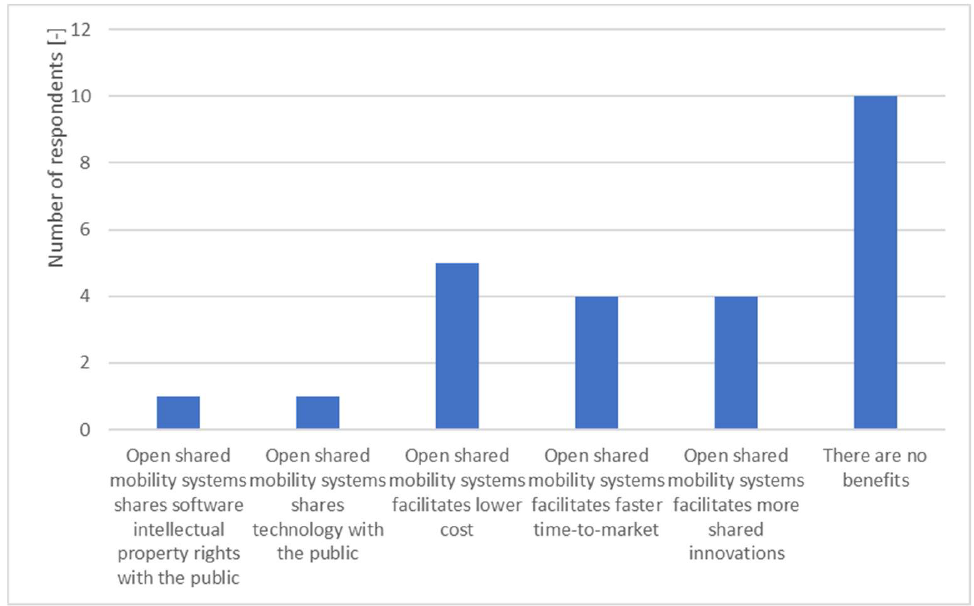
Figure 14. Perception of data sharing as a problem.